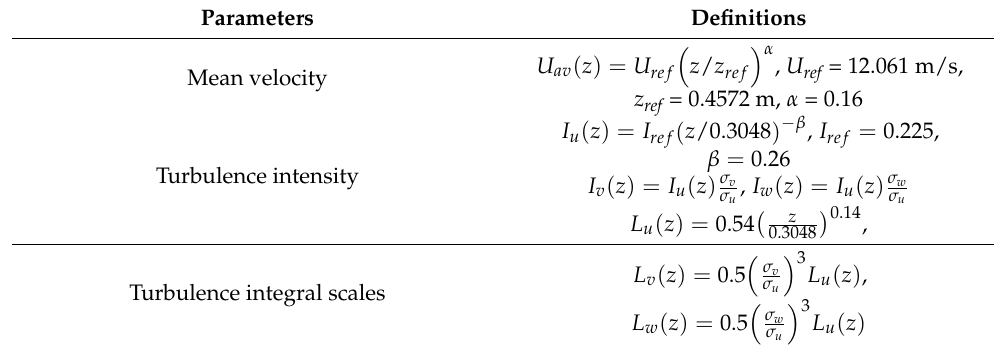
Table 3. CAARC model numerical simulation of turbulent wind field parameter